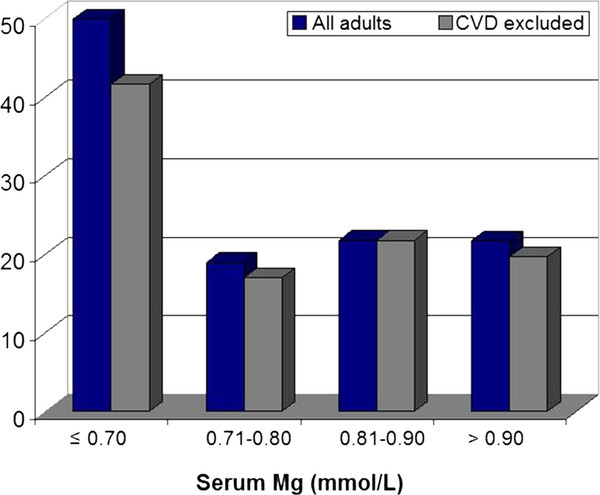
PVC prevalence (%) during 2-hr Holters among adults (n = 750) according to sMg concentrations (mmol/L)1. Legend: CVD excluded (grey bars) omits individuals with cardiovascular event history or conditions. Difference in PVC prevalence among participants with sMg ≤ 0.70 vs. > 0.70 mmol/L among all adults (blue bars): p = 0.015; for CVD excluded (grey bars): p = 0.07.